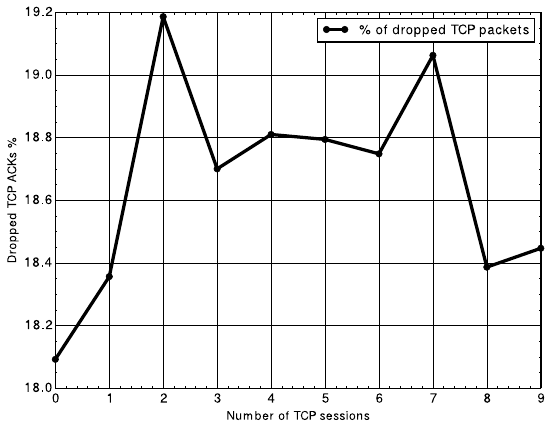
Fig. 9. Percentage of dropped TCP ACKs compared to the total amount of packets on Ethernet